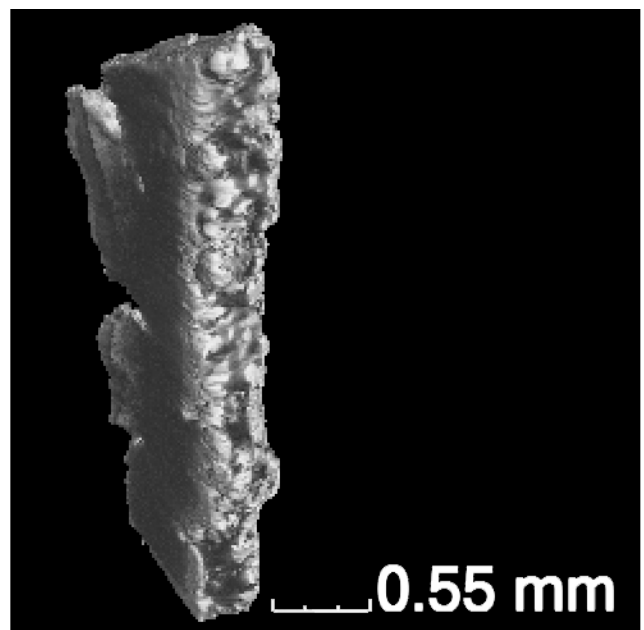
Figure 1. Three-dimensional image of the TiNi–TiB 2 metal–matrix composite obtained by direct laser deposition.